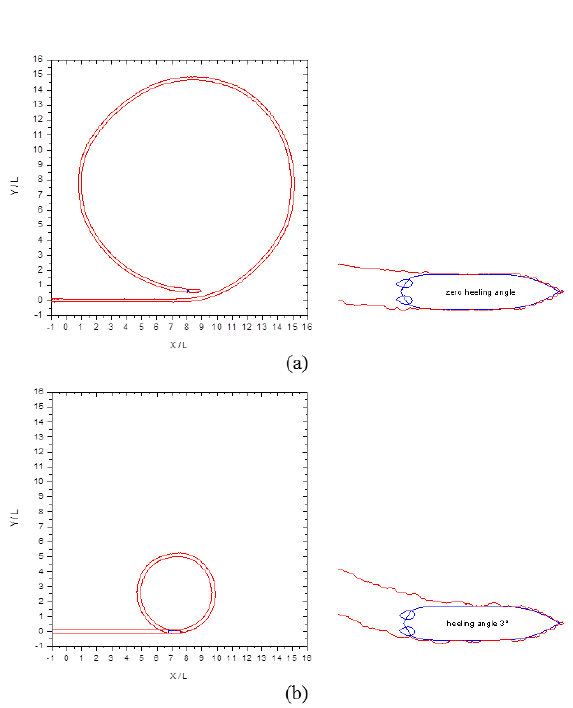
Figure 22: Simulated turning circle diameters in differ- ent ice conditions (power 120%, azimuth an- gle 35 ◦ ). The turning circle diameter D t is divided by ship length L . All numbers are at model scale.